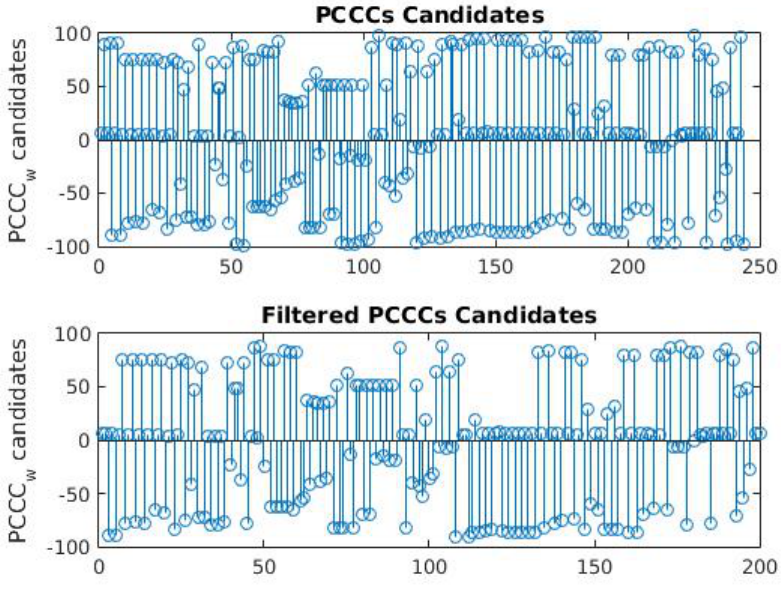
Figure 3. PCC candidates in upper row. PCC candidates after outlier